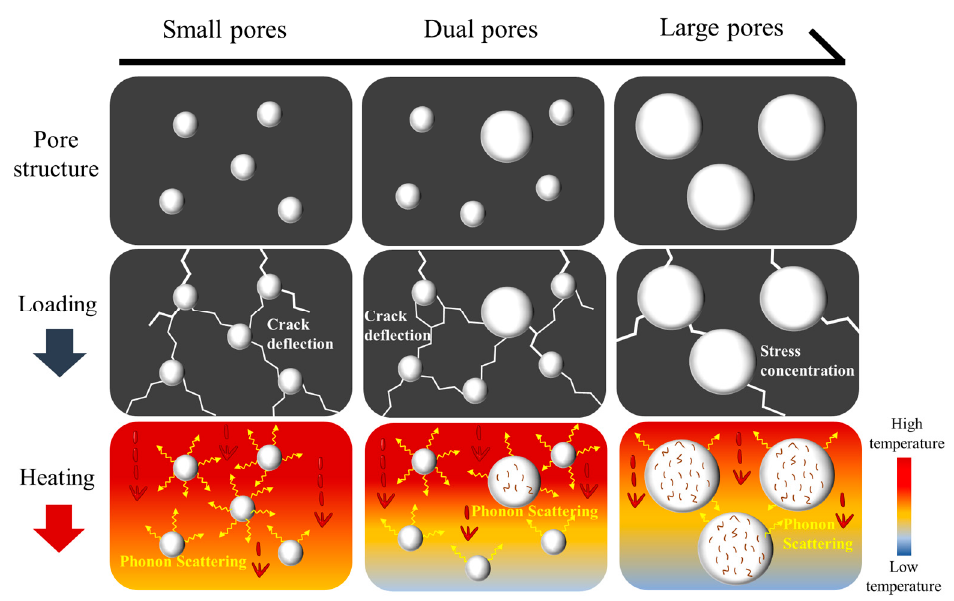
Figure 10. Pressure resistance and thermal conductivity mechanism diagram of dual-porosity high- entropy ceramics.